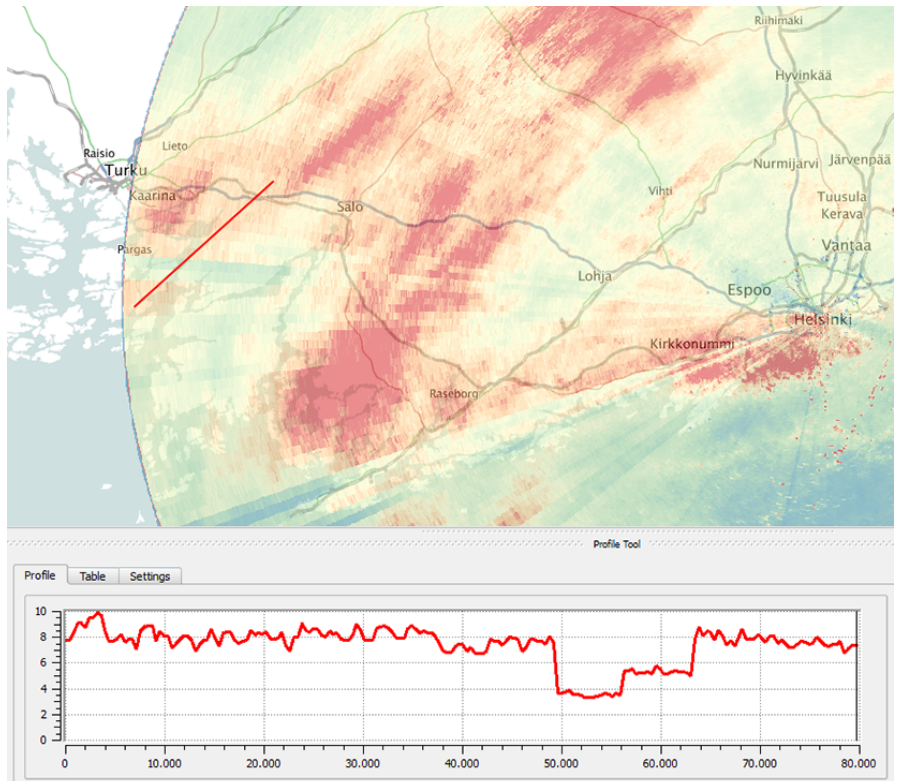
Figure 8. Example of rain profile (mm) on 22 September 2014 along the red line used to estimate the partial beam blockage for the Kumpula weather radar. The x axis reports distance in meters from northeast to southwest.